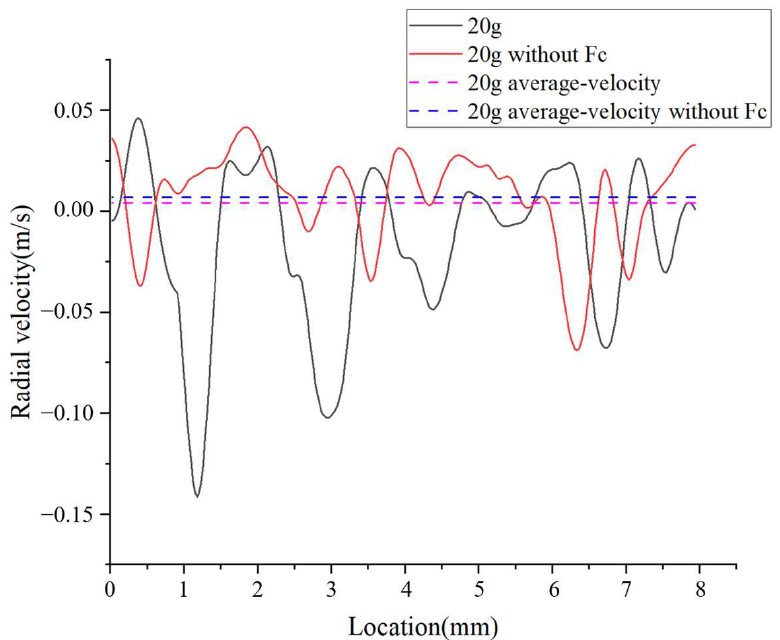
Figure 18. The radial velocity distribution along axis direction (20 g).